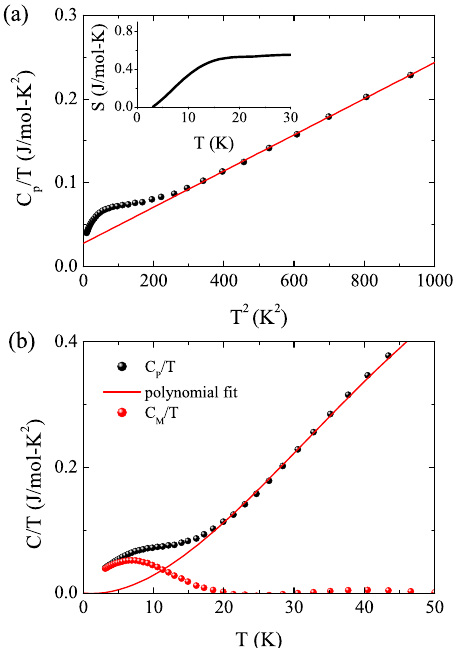
Figure 5. (Color online) ( a ) C p / T vs. T 2 plot at low temperatures. The red curve is a fit as described in the text. The inset shows the entropy change below 30 K; ( b ) Subtraction of the phonon component from C p /T by a polynomial